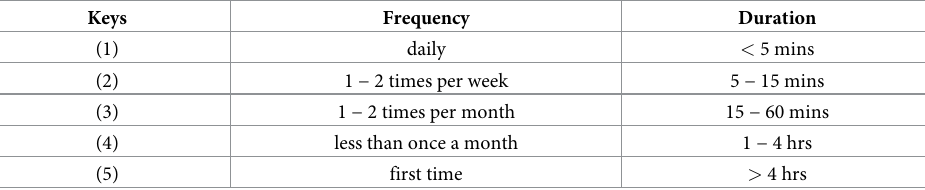
Table 2. Possible responses on POLYMOD survey concerning frequency and duration of